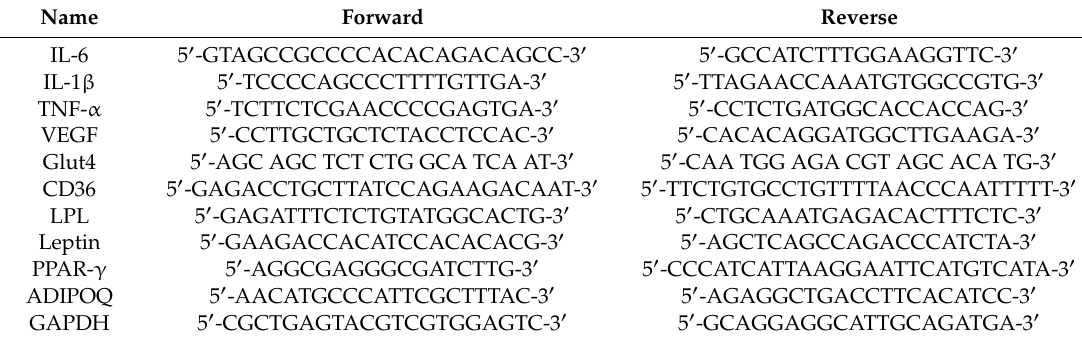
Table 2. List of primers used for real-time quantitative PCR